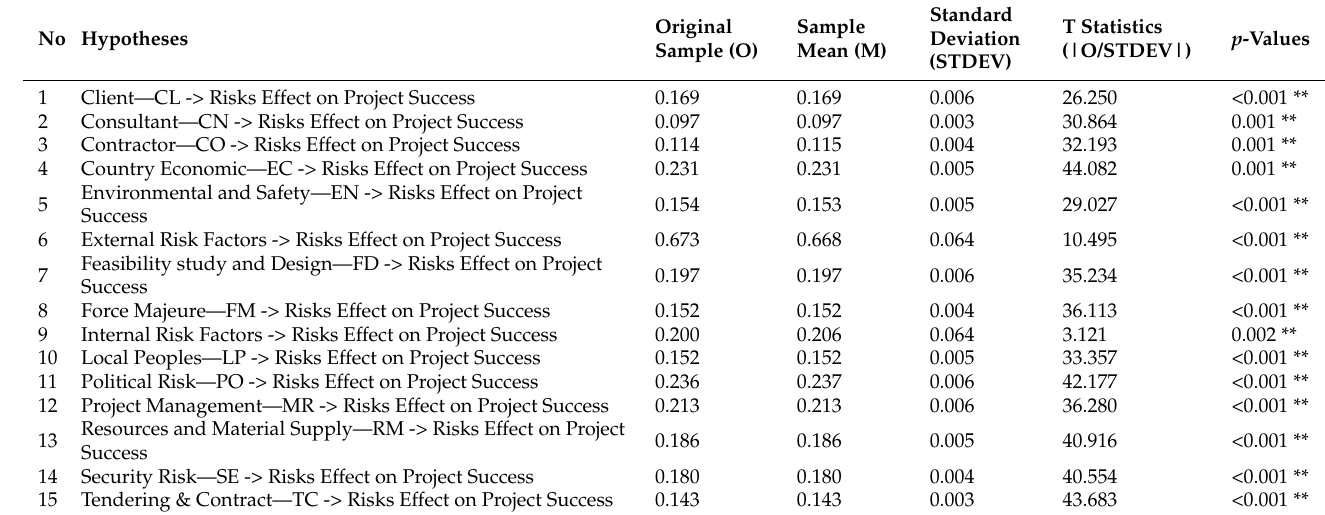
Table 11. The research hypotheses path coefficient.